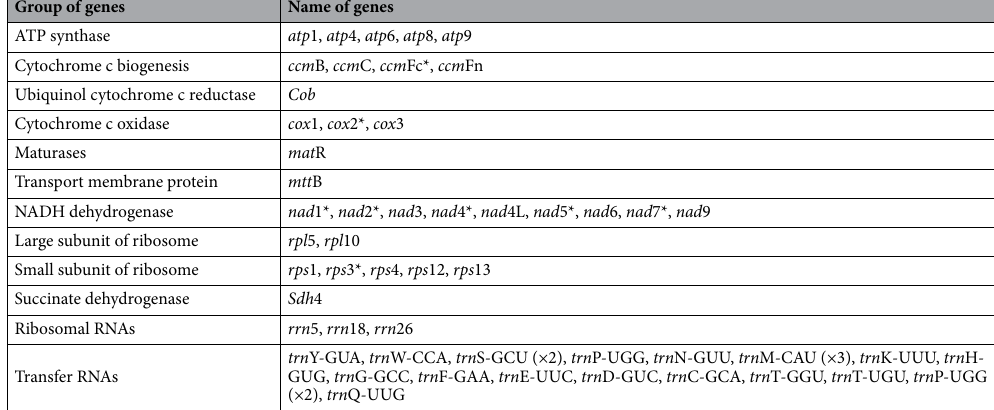
Table 1. Gene composition in the A. giraldii mitogenome. ‘*’ genes that contain introns.